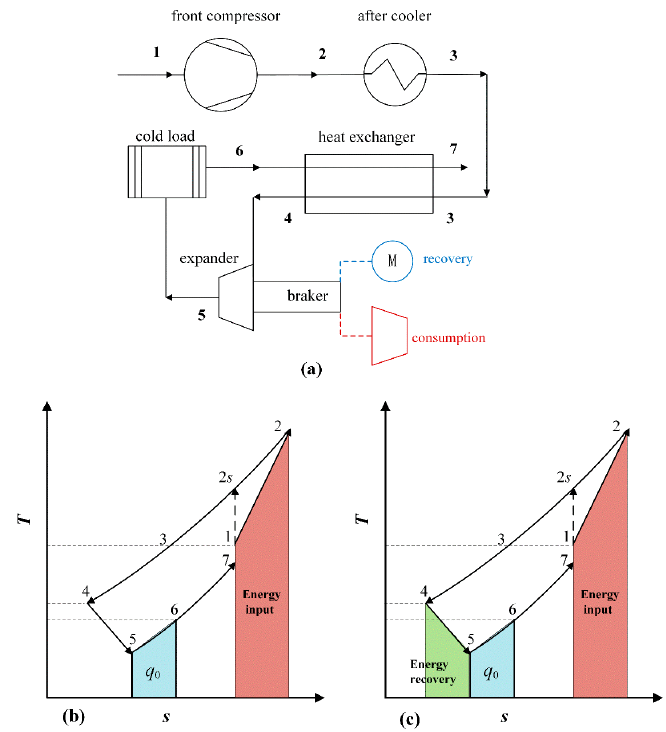
Figure 1. Flow process and T-s diagram of a cryogenic reverse Brayton refrigerator: ( a ) Flow process; ( b ) T-s diagram of energy consumption; ( c ) T-s diagram of energy recovery.